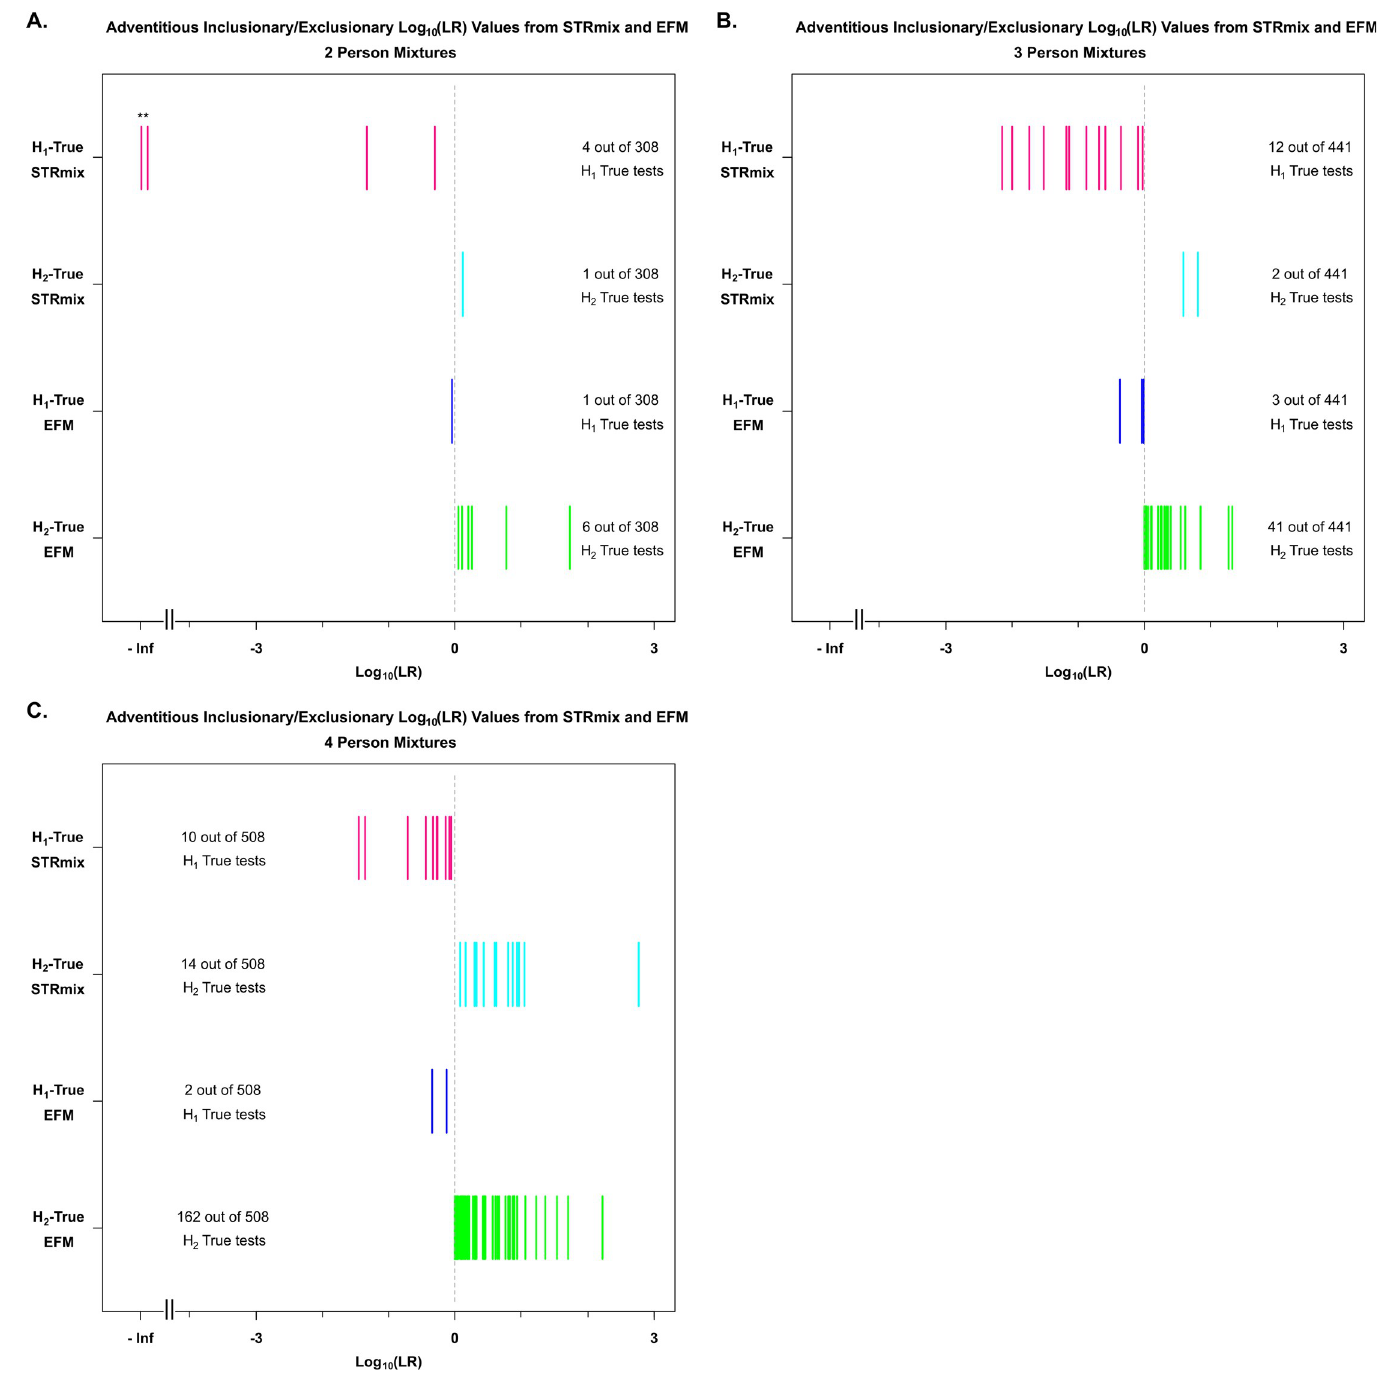
Fig 3. Summary of adventitious exclusionary and inclusionary support from both LR systems with their corresponding log 10 (LR) values. The x-axis shows the log 10 (LR) values for these adventitious exclusionary and inclusionary cases. The y-axis shows the labels of the tested propositions (H1 and H2) from each software (STRmix and EFM). �� in (A.) are the two 2P H1-true test interpretations for which STRmix assigned profile LRs of 0 (plotted in magenta at–Infinity (-Inf) on the log 10 scale and discussed in detail in Section